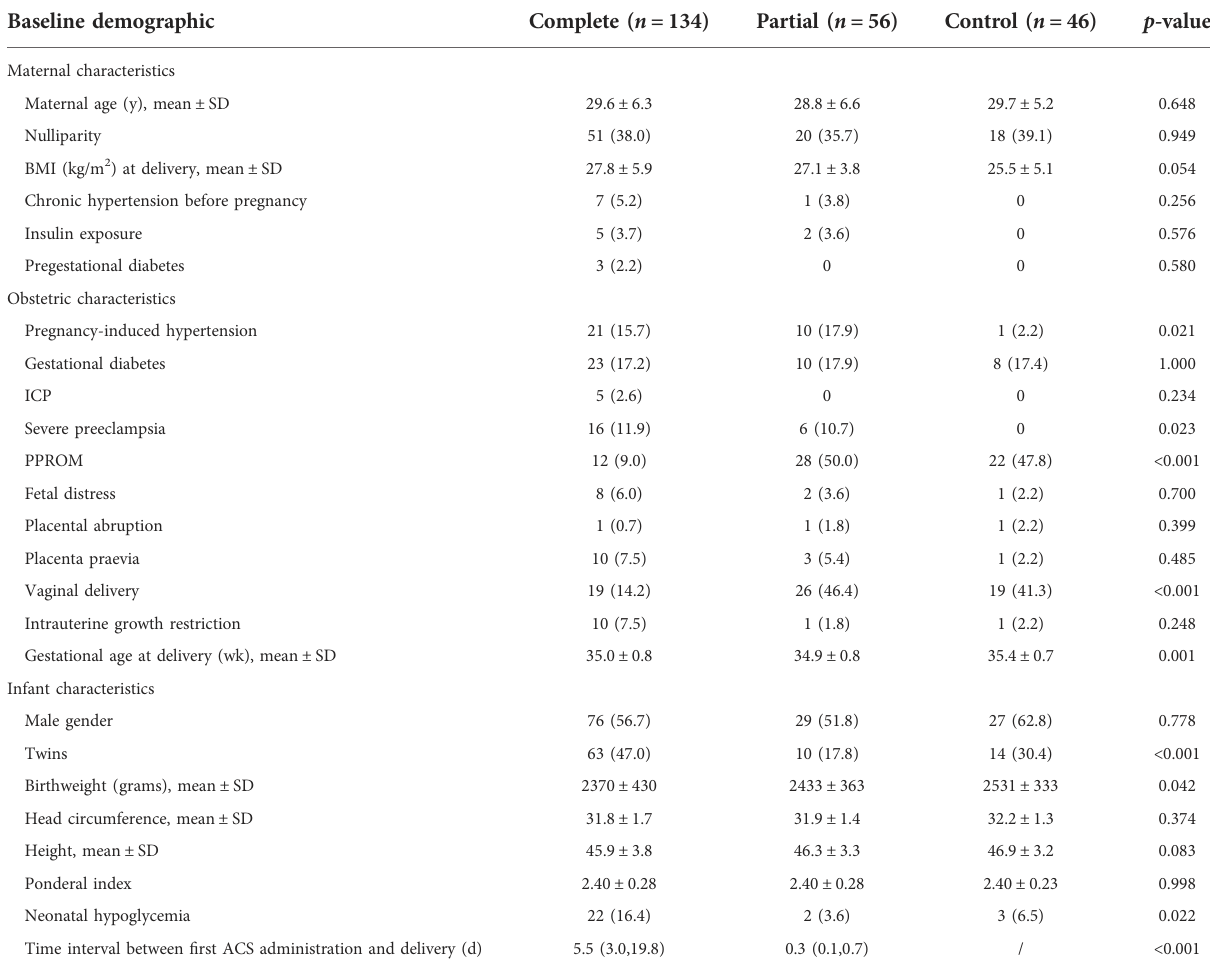
TABLE 1 Baseline maternal and infant characteristics in the study population.